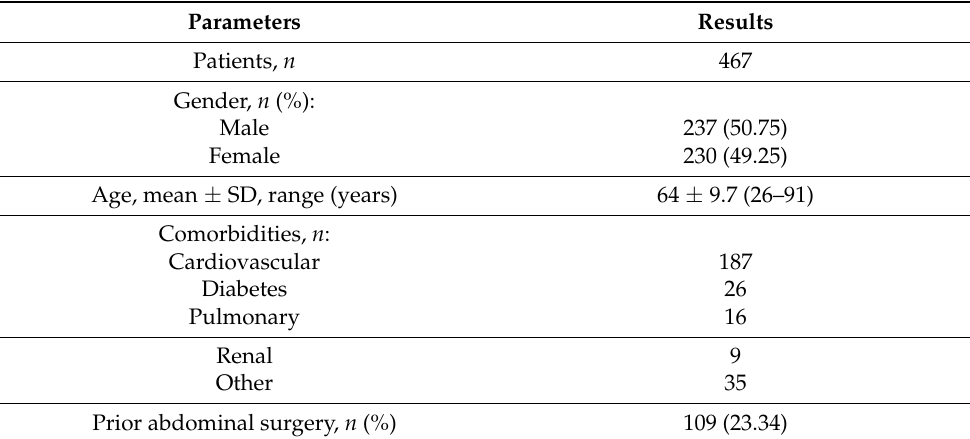
Table 1. Demographic data of included